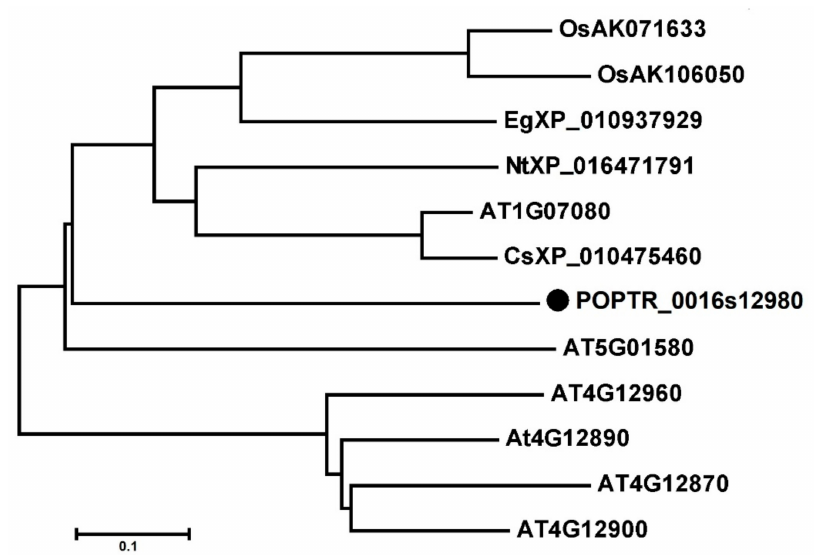
Figure 1. The phylogenetic tree analysis of OSH1 proteins. Translated amino acid sequence of POPTR_0016s12980 was compared using the BLASTP search program. GenBank accession number is preceded by a species identifier. Pt, Populus trichocarpa ; At, Arabidopsis thaliana ; Os, Oryza sativa ; Nt, Nicotiana tabacum ; Cs, Camelina sativa ; Eg, Elaeis guineensis .